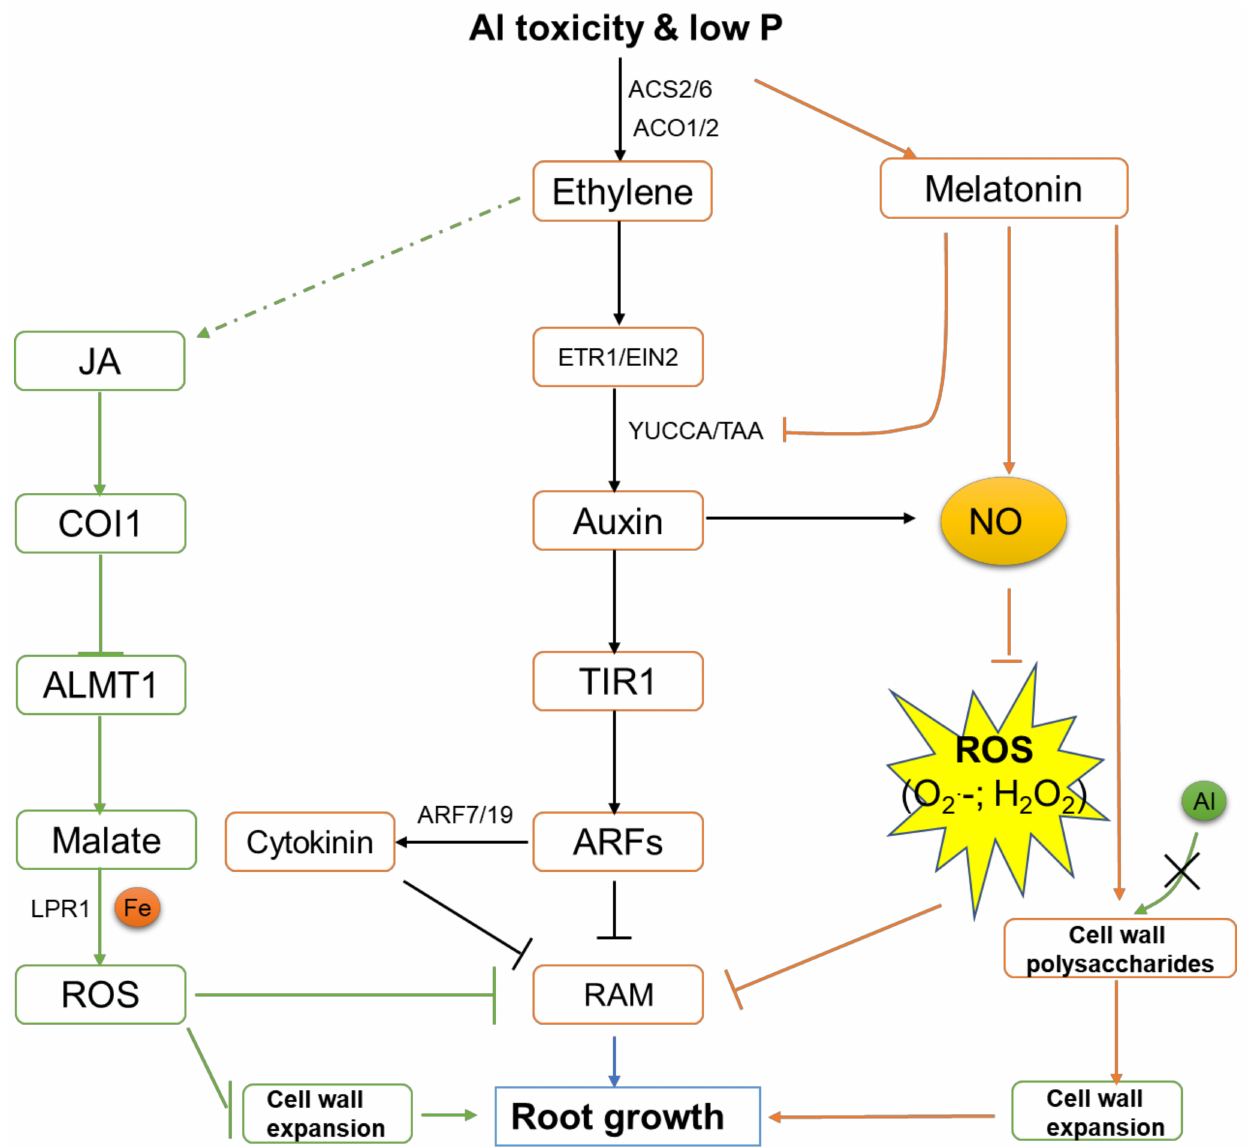
Figure 3. A simplified model for the relationship among different hormones in response to both Al toxicity and low P. Al stress and P deficiency induce the local up-regulation of TRYPTOPHAN AMINOTRANSFERASE OF ARABIDOPSIS 1 (TAA1) and YUCCA (YUC) in the root transition